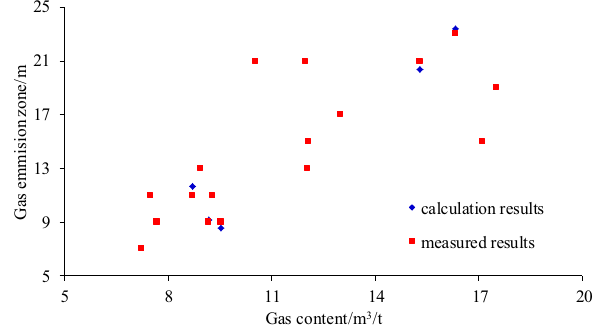
Figure 13. The calculated and measured results of gas emission